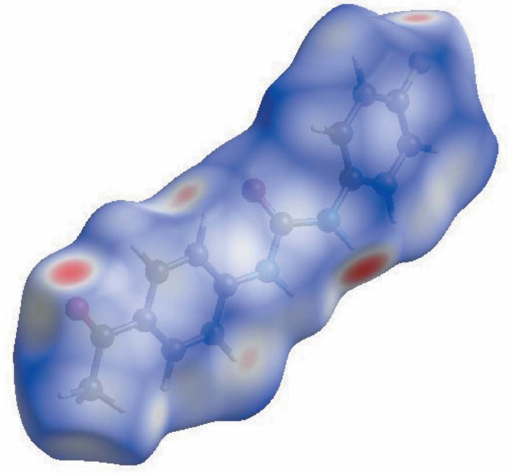
Figure 2 A view along the a axis of the crystal packing of the title compound. H atoms not involved in hydrogen bonding (dotted lines) are omitted for clarity.